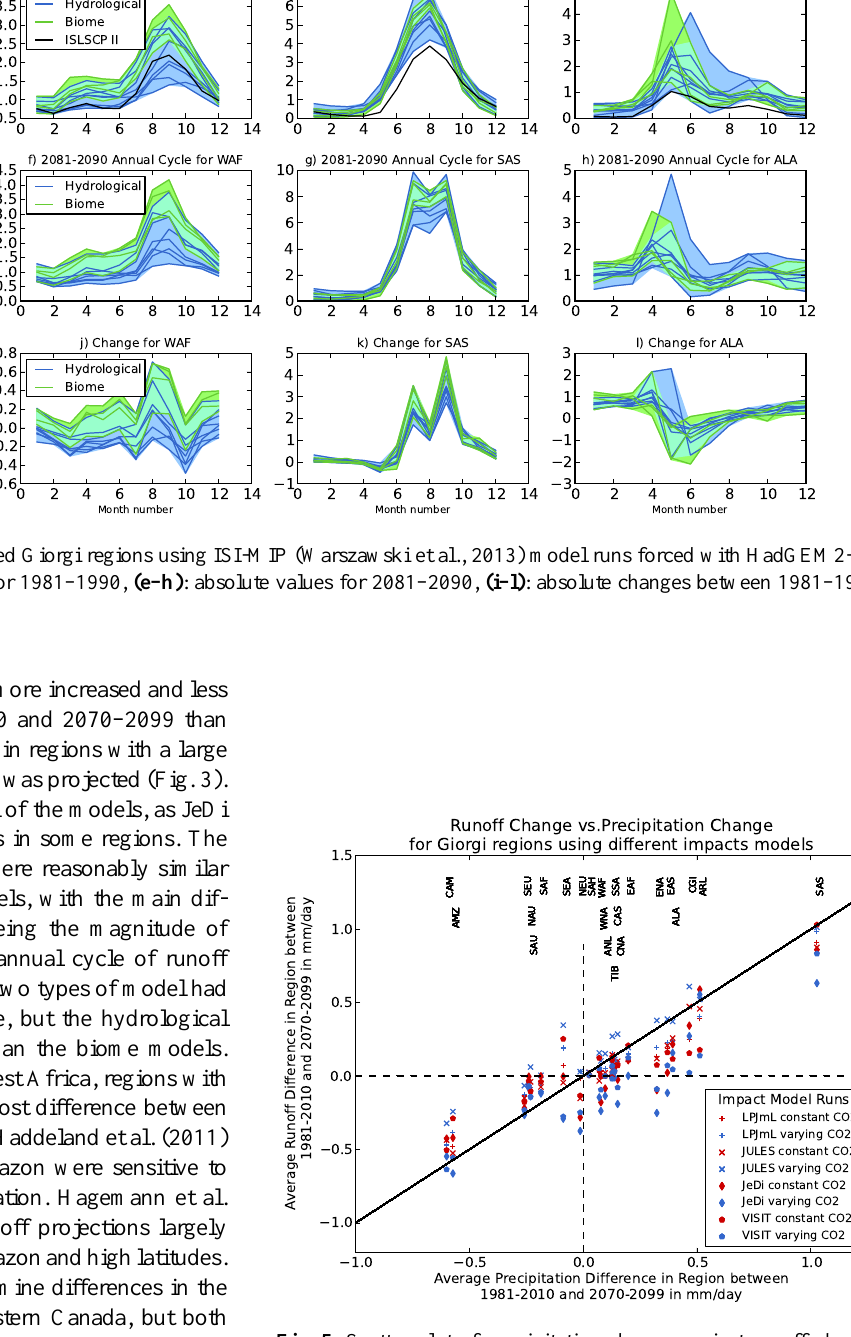
Fig. 5. Scatter plot of precipitation change against runoff change between 1981–2010 and 2070–2099 in mm day − 1 for the Giorgi re- gions – for models including both varying and constant CO 2 forced with HadGEM2-ES RCP8.5 climate. Solid 1 : 1 line. Dashed x = 0 line and y = 0